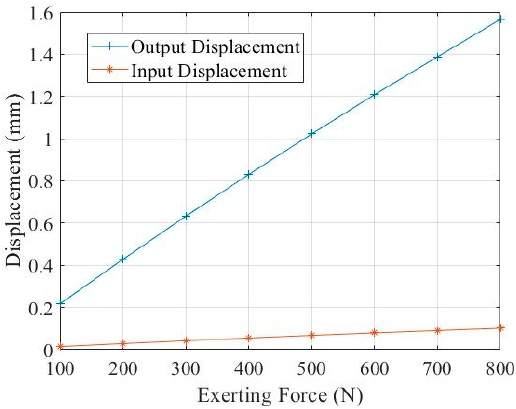
Figure 14. Relationship between input and output.